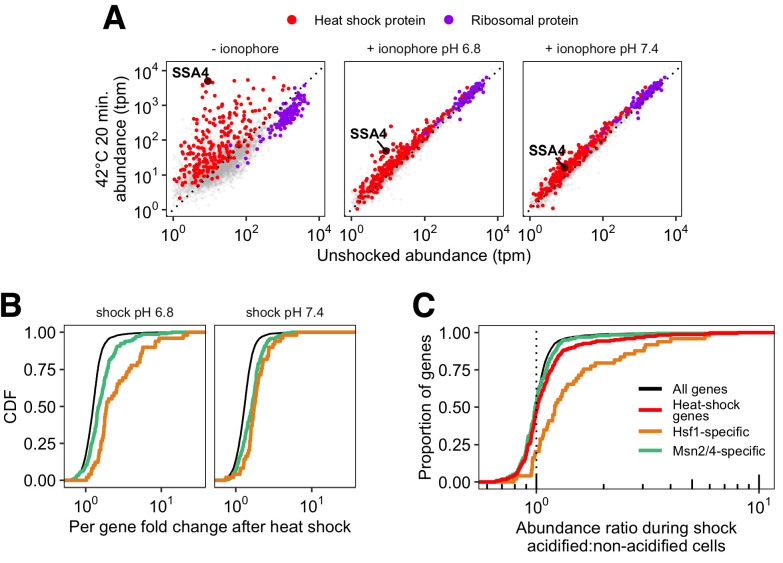
Gene induction and pH sensitivity after heat stress following pH manipulation with ionophore.(A) Induction of heat shock genes in cells heat shocked without ionophore in acidic media (left panel), or in ionophore (center and right panels). (B) Induction (fold change in stressed cells relative to unstressed cells) for genes belonging to the Hsf1 (orange) and Msn2/4 (green) regulons. (C) Cumulative distribution of per-gene transcript abundance in cells heat shocked at pH 6.8 relative to cells shocked at pH 7.4 (induction ratio). The red line shows all heat shock proteins; this group is further divided into genes regulated by Msn2/4 (green) which show similar behavior to all detected transcripts (gray; P=.402, Wilcoxon rank sum test), and those regulated by Hsf1 (orange), which are significantly higher in acidified cells (P<0.01, Wilcoxon rank sum test).